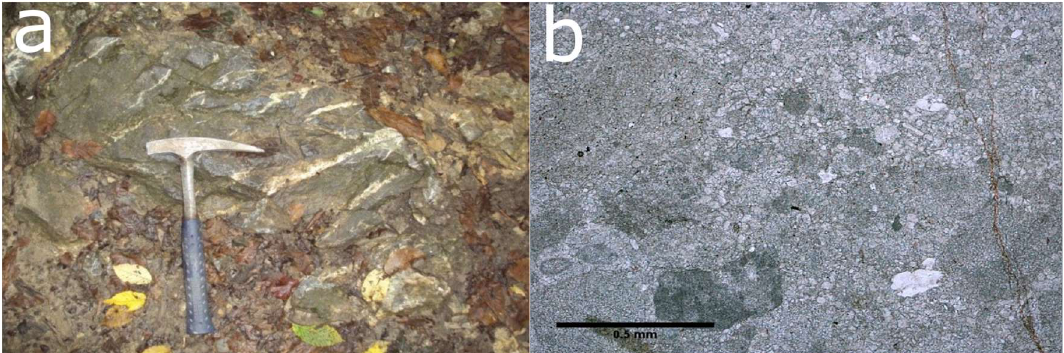
Figure 4. ( a ) Outcrop with dark gray dolomite in the Medvednica mountains; ( b ) photomicrograph of brecciated dark gray dolomite (width of the photomicrograph is 1.7 mm).